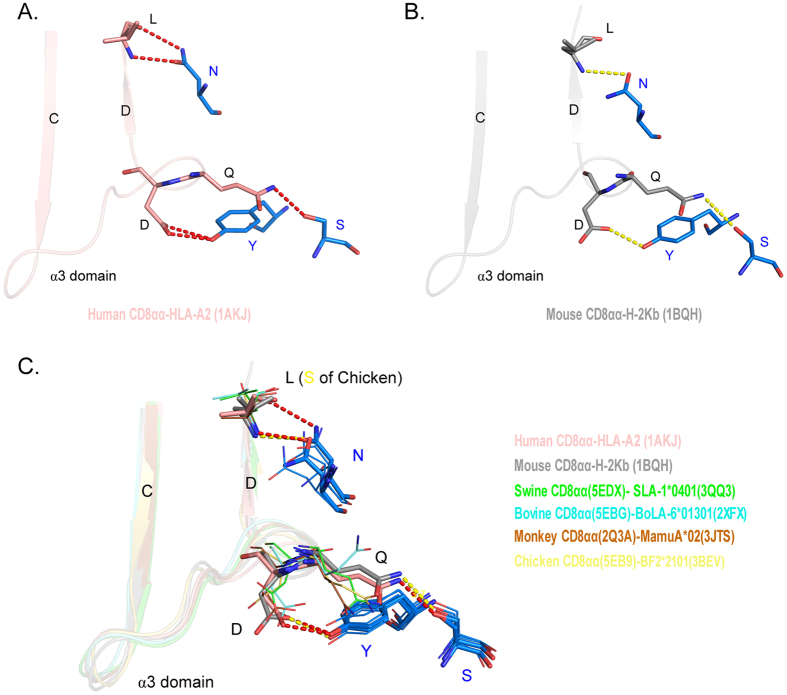
The key conserved residues maintain the interaction between CD8α and MHC I molecules.(A) The key conserved residues on the interface of human CD8αα and p/MHC I. The hydrogen bonds in the human MHC I-CD8αα complex (PDB ID: 1AKJ) are shown as red dashed lines. (B) The key conserved residues on the interface of mouse CD8αα and p/MHC I. The hydrogen bonds in the mouse MHC I-CD8αα complex (PDB ID: 1BQH) are shown as yellow dashed lines. (C) The conserved manner of interaction between p/MHC I and CD8αα. The MHC I and CD8αα of six different species are aligned according to human and mouse MHC I-CD8αα crystal structures. Human and mouse residues are shown in stick form, and chicken, swine, bovine and monkey residues are shown as lines. The CD8αα and p/MHC I structures used for the model are listed on the right side.